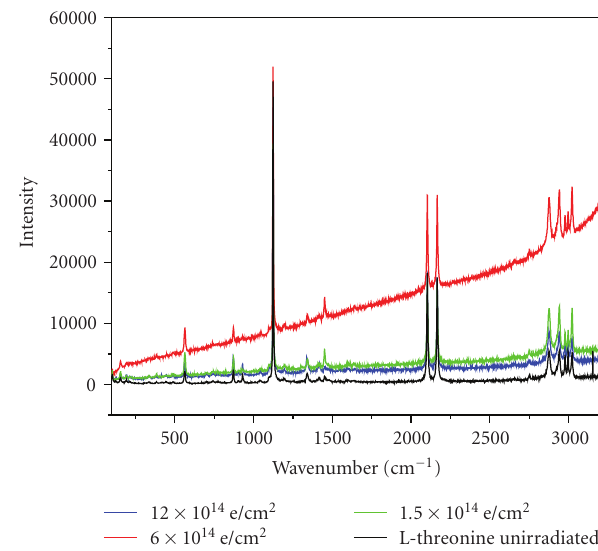
Figure 42: Micro-Raman spectra of pure and electron-irradiated L-threonine crystal at various